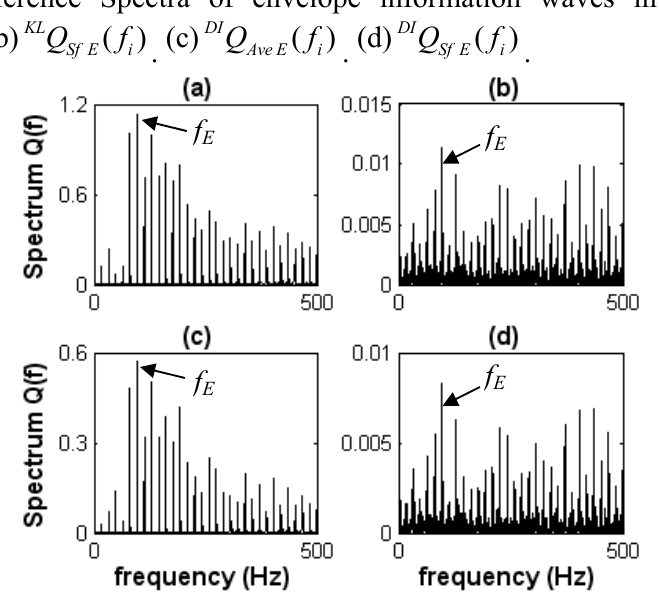
Figure 16. Difference Spectra of envelope information waves in the roller